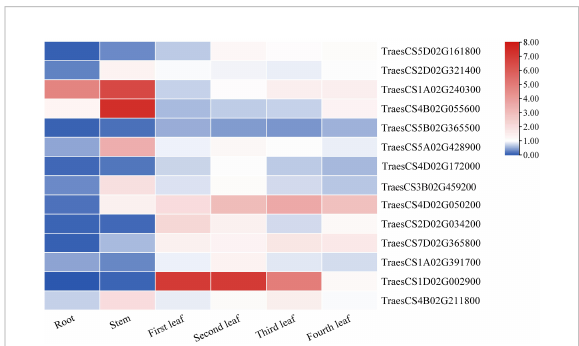
FIGURE 6 The differential expression of 14 representative TaRR-RLKs from each subfamily in different tissues was analyzed by qRT-PCR. The plants were divided into seven different tissues including root, stem, fi rst leaf, second leaf, third leaf, fourth leaf, and fi fth leaf and the fi fth leaf as a control. Data shown are the means of three biological replicates ± the SE and visualized in TBtools. The values were normalized to those for TaCDC and are presented as fold changes in expression relative to that in wheat leaves without treatment. The mean expression values were visualized by Tbtools. The color scale represents expression values of each sample. The blue box represents the lower levels and the red box represent high levels of expression level. The qRT-PCR values used for the heat map are listed in Supplementary Table S11.